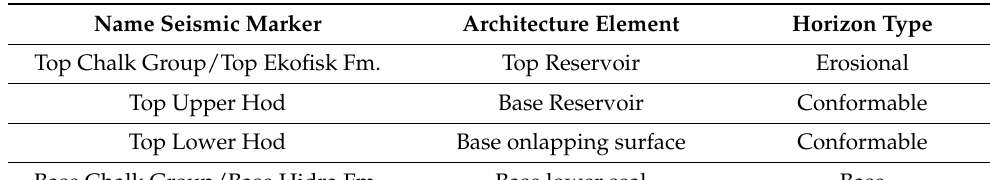
Table 1. Seismic interpretation parameters.